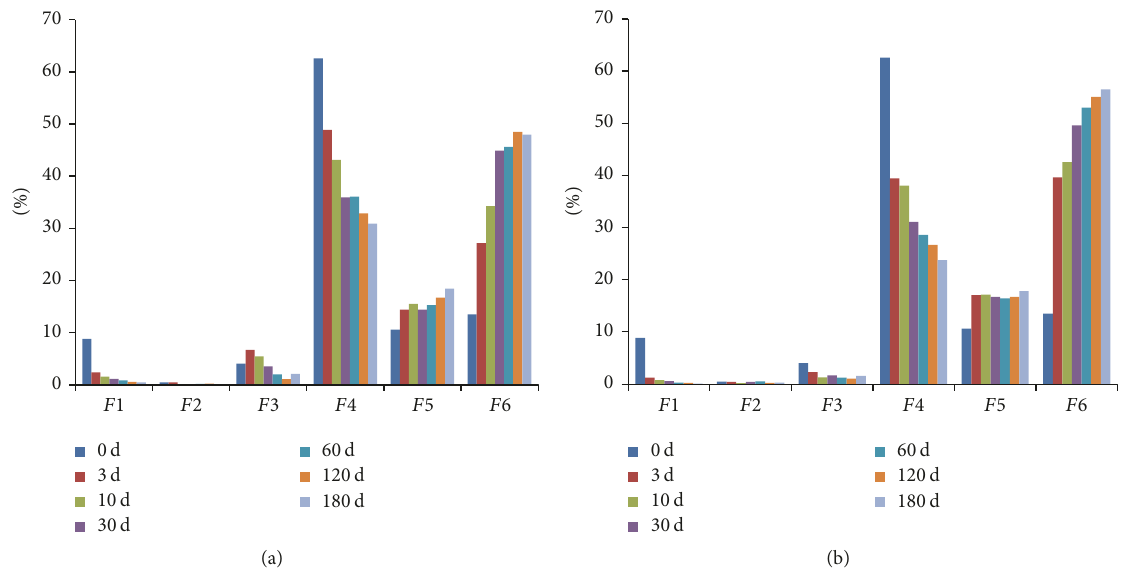
Figure 5: The stabilization processes of As in soils at different redox conditions ((a) S IN and (b) S IA ).